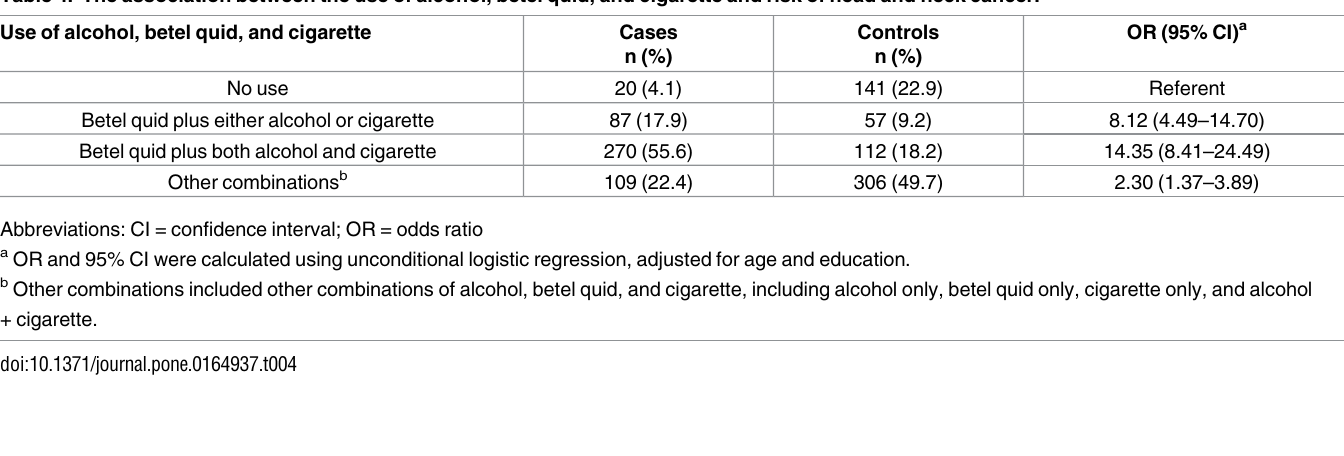
Abbreviations: CI = confidence interval; OR = odds ratio a OR and 95% CI were calculated using unconditional logistic regression, adjusted for age, education, cigarette smoking (pack-year categories), and alcohol drinking (frequency) b Other oropharynx = soft palate (n = 2) and unspecified subsites of oropharynx (n = 27)